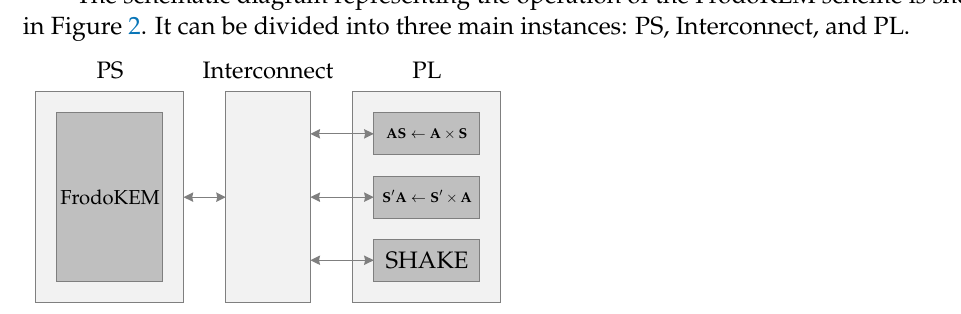
Figure 2. Schematic representation of the structure. The arrows represent 32-bit buses. Control signals have been omitted.